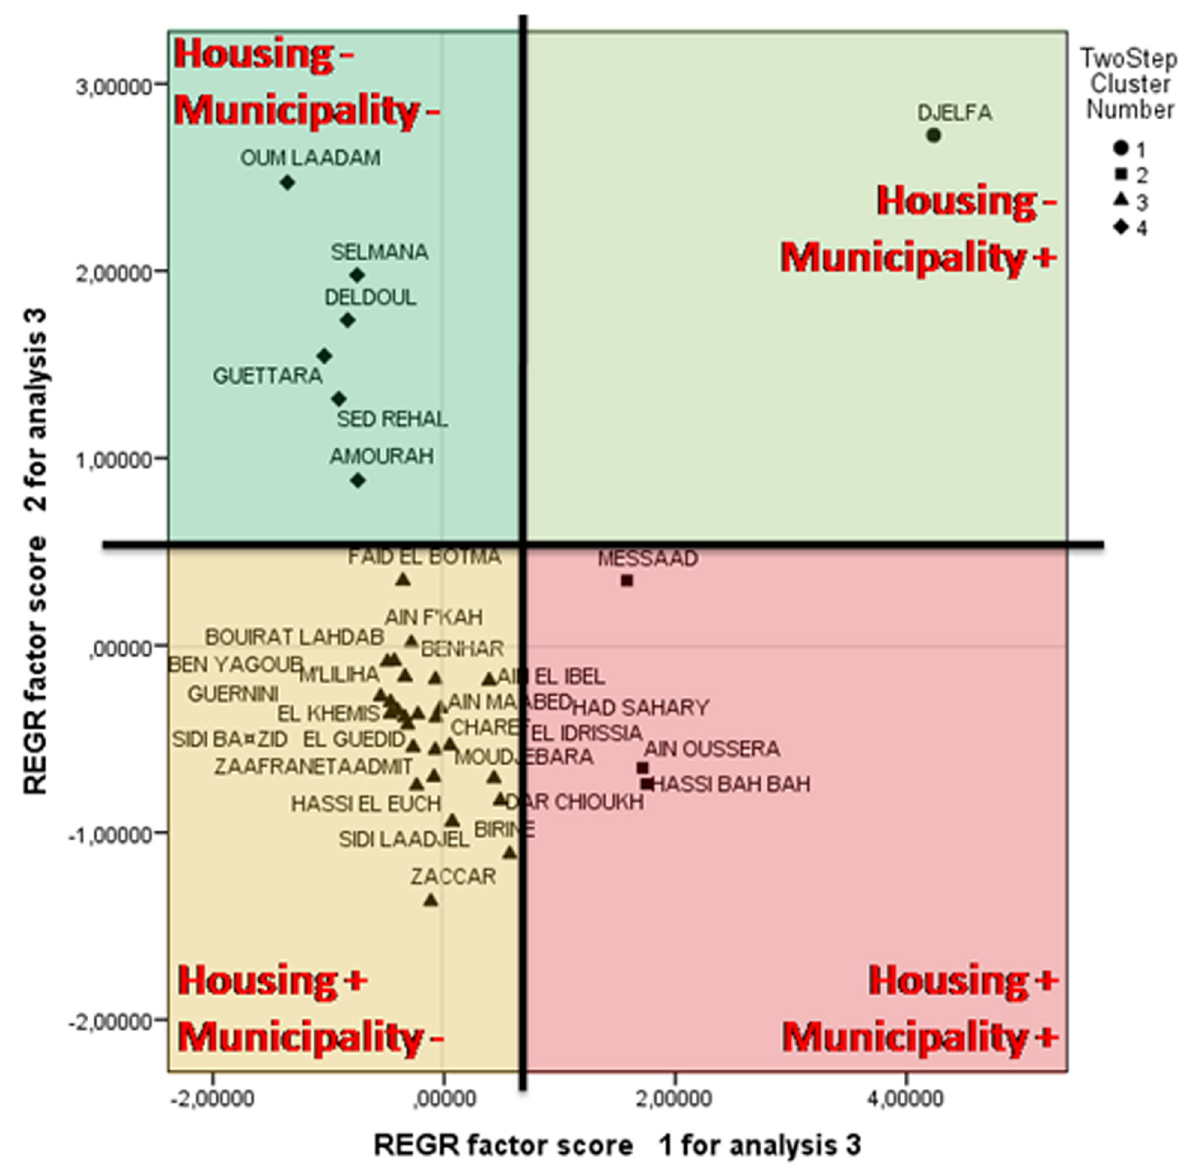
fig. 7. Projection of municipalities according to